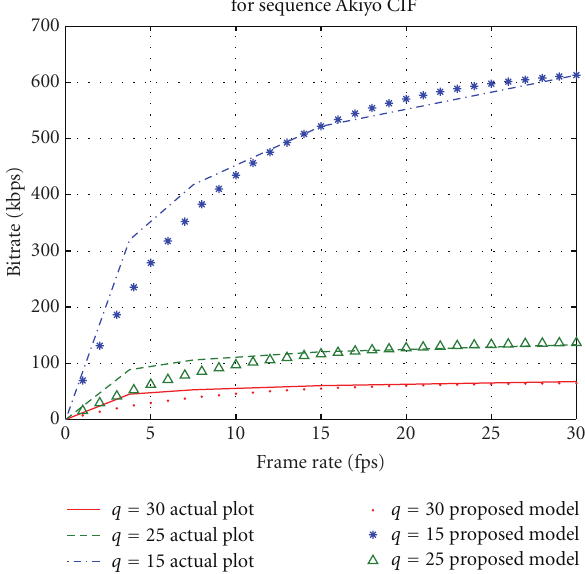
Figure 4: Plot showing proposed bitrate following actual bitrate at q = 15, 25, and 30.